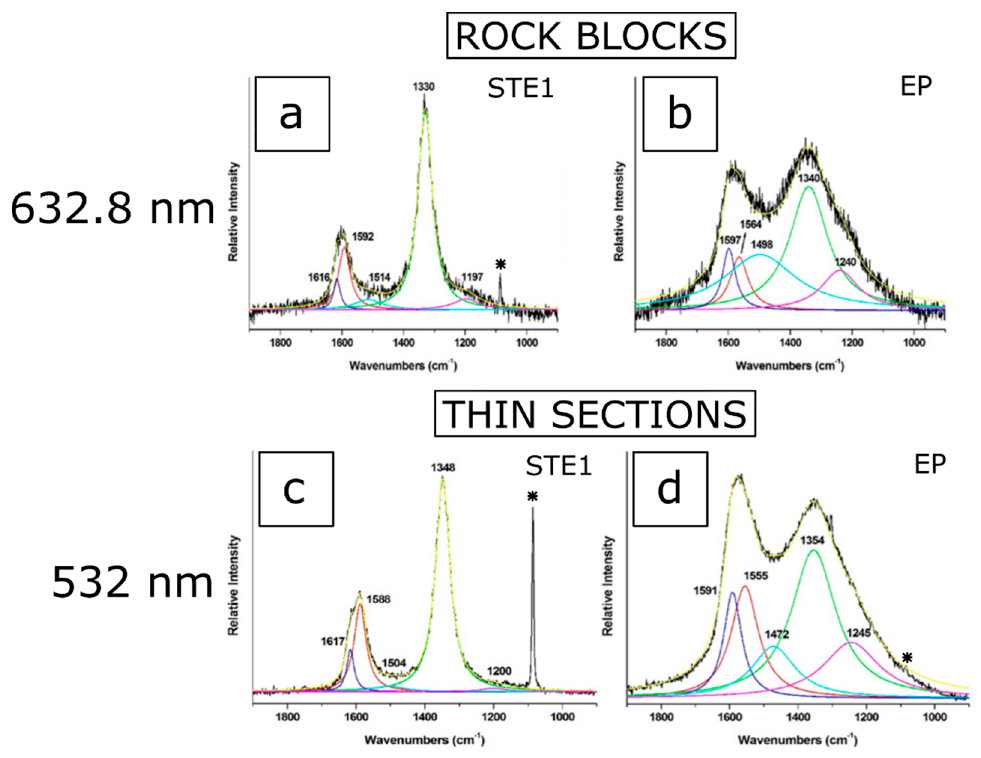
Figure 6. 632 nm ( a , b ) vs. 532 nm ( c , d ) laser sources and rock block ( a , b ) vs. thin section ( c , d ). The Raman band indicated by the * is ascribed to calcite (CaCO 3 ), which is the main component of the rock.